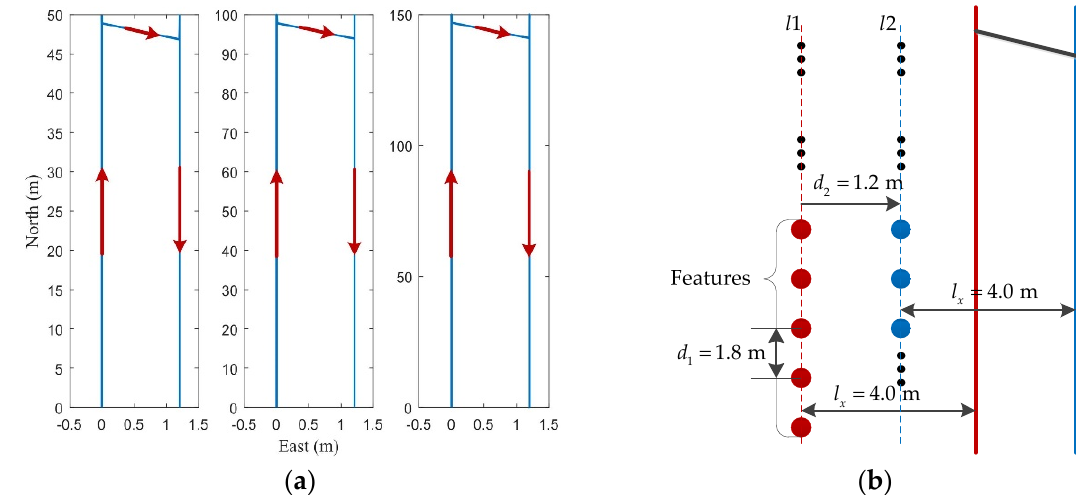
Figure 7. Trajectory shape and feature distribution: ( a ) trajectories of different lengths; ( b ) the spatial relationship between trajectory and features.